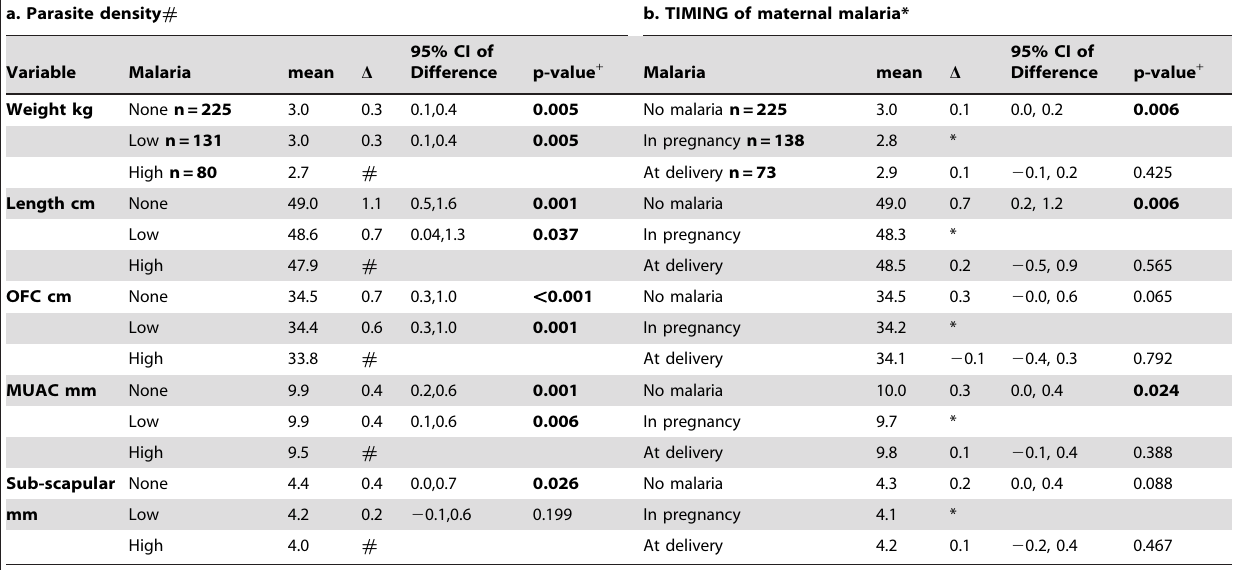
Table 3. Associations between growth characteristics and blood pressure at birth defined by Parasite density and Timing of